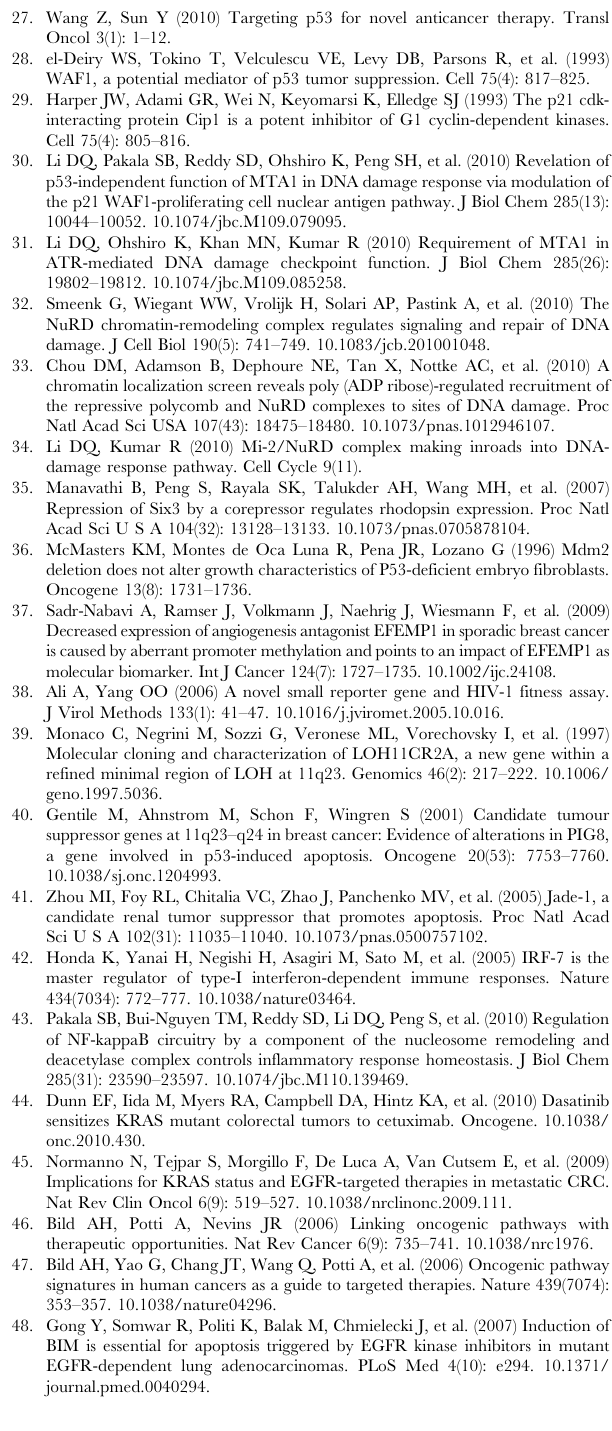
Table S10 Primer sequences for the candidate genes of Mus Musculus and Homo sapiens that were used in the RT-qPCR assays are